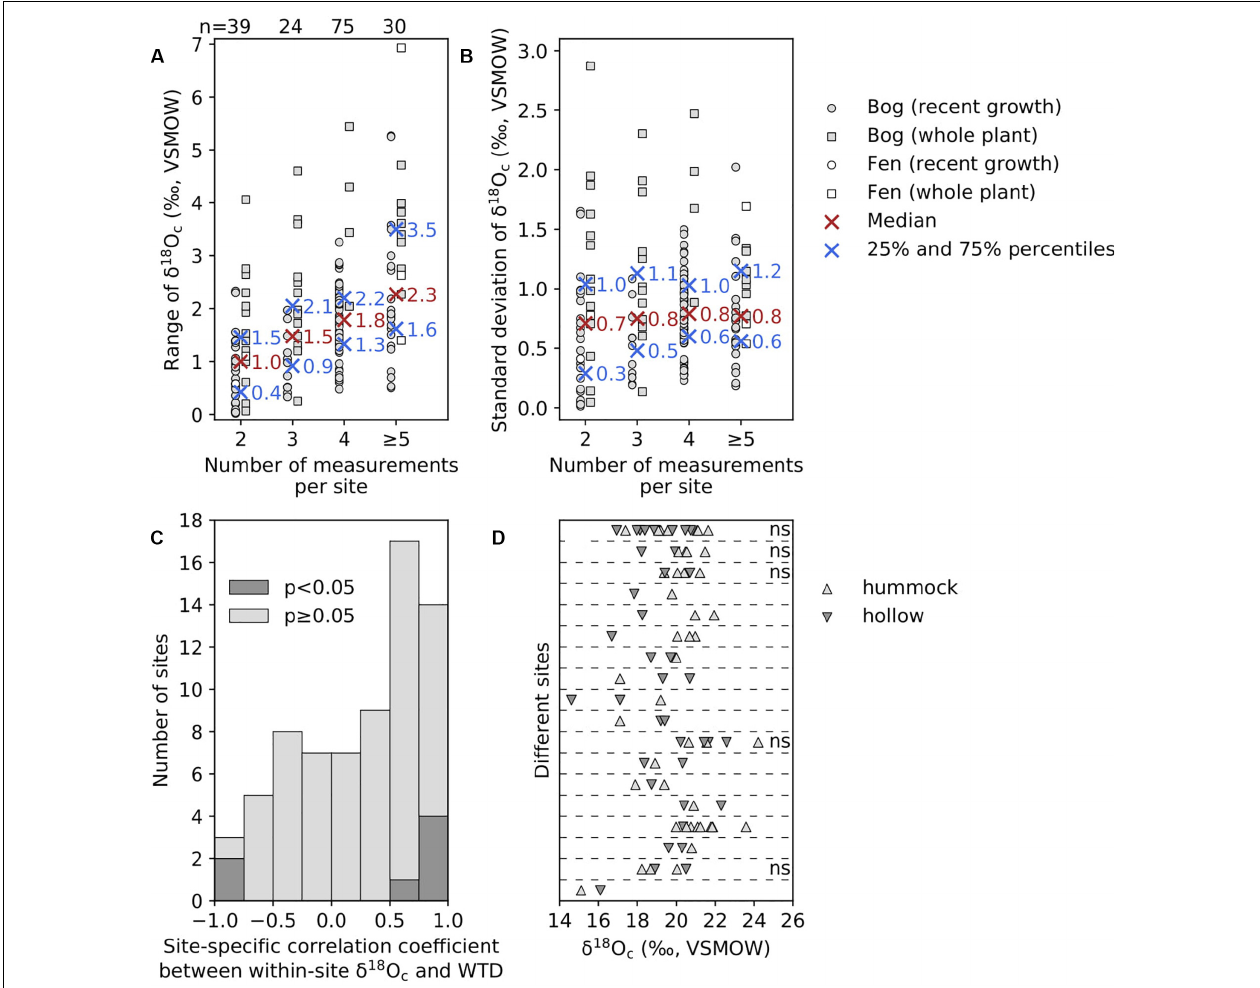
FIGURE 3 | Within-site variability of Sphagnum δ 18 O c data. (A) Range of within-site δ 18 O c data for each site. (B) Standard deviation of within-site δ 18 O c data for each site. In both (A,B) , results are separated for the number of measurements per site. Individual site data are separated for bogs and fens and for recent growth and whole plant parts. Also shown are median and lower/upper quartile values of the range and the standard deviation as cross symbols. The numbers of sites are indicated on top of plot in (A) . (C) Histogram of site-specific correlation coefficient between within-site δ 18 O c and WTD data from studies by Loader et al. (2016), Granath et al. (2018), Jones et al. (2019), and Xia et al. (2020) in which WTD measurements are available and there are at least three data points. The significant correlations with p -value lower than 0.05 are shown as dark gray color. Positive correlation indicates that high δ 18 O c correspond to deep WTD. (D) Within-site δ 18 O c data from studies by Taylor (2008) and Brader (2013), plus a site from this study, in which samples were collected at microtopographical locations of hummock and hollow. Data from different sites are separated by horizontal lines. The “ns” denotes “not significant” difference at p < 0.05 level in Student’s t -test